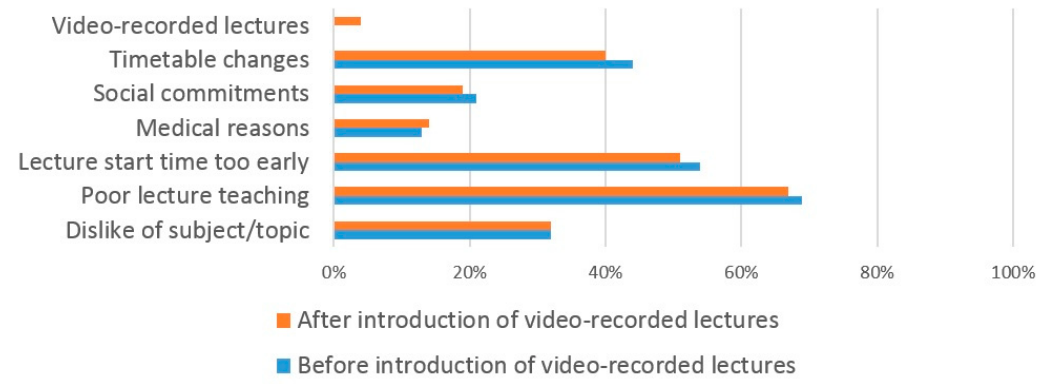
Figure 6. The reasons why medical students miss lectures.